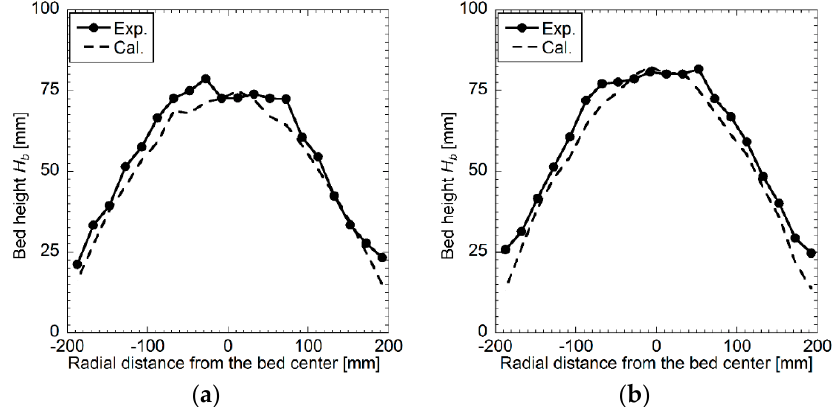
Figure 4. Side-view height of the homogeneous particle bed in the radial direction: ( a ) Case 1; ( b ) Case 2.